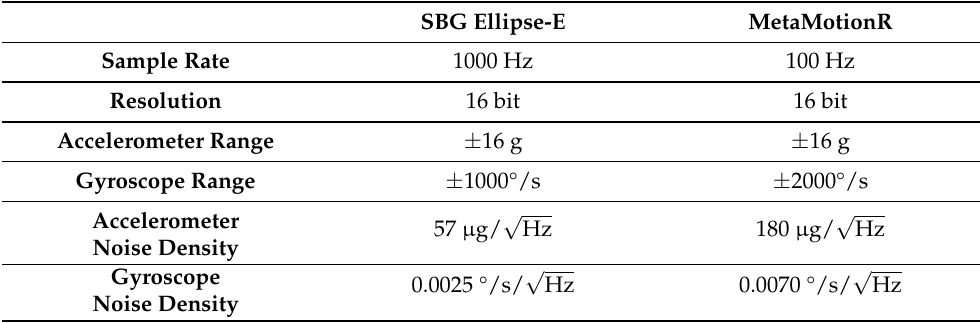
Table 1. Sensors’ main